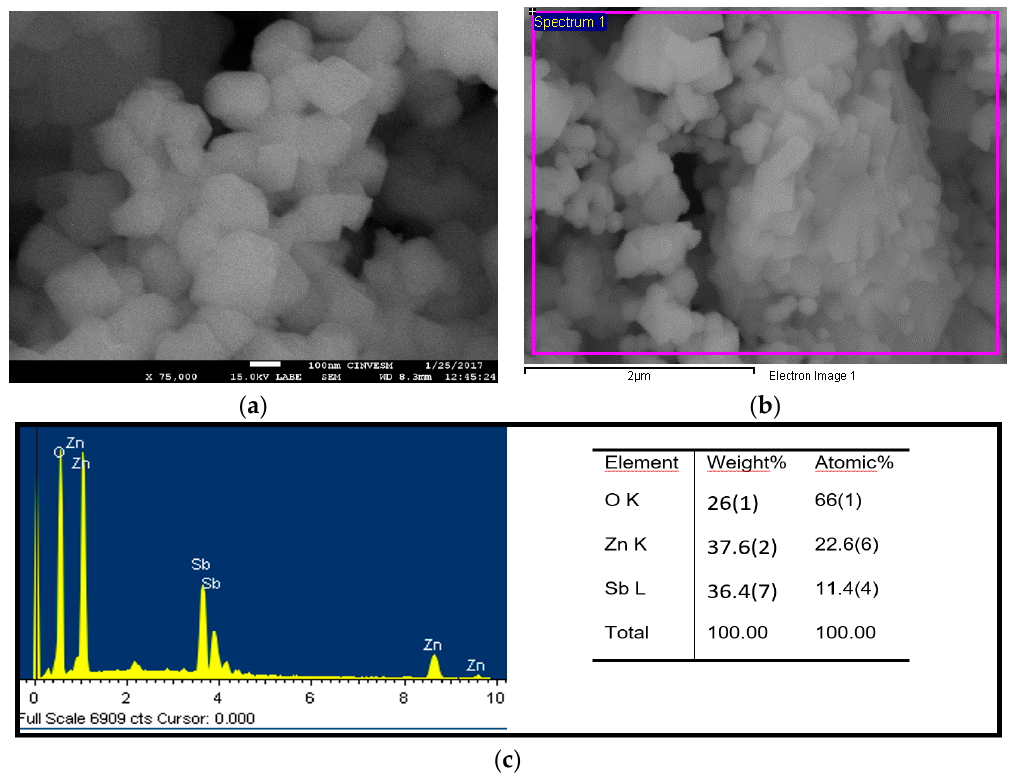
Figure 4. ( a ) SEM observation of particles morphology. ( b ) Representative area for The EDXS measurement. Approximate dimensions: 4 × 3 µm 2 . ( c ) EDXS elemental analysis.